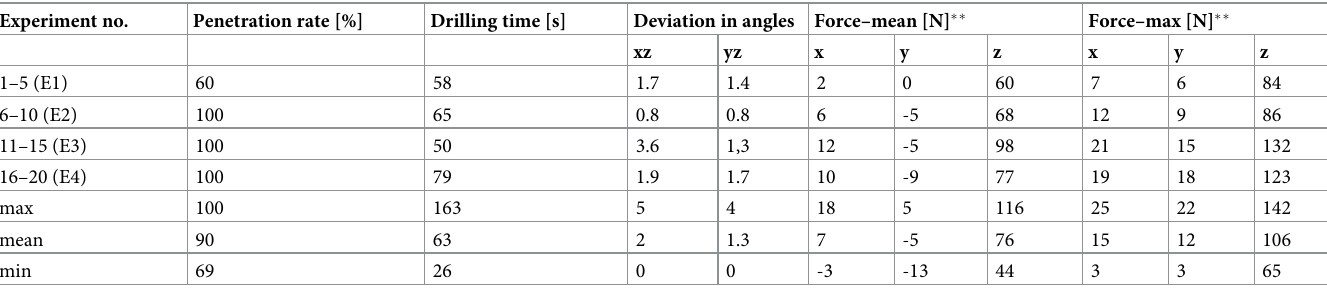
Table 2. Parameters of electrical drilling, Part 1 (E+no = mean of 5 drilling procedures). Experiment